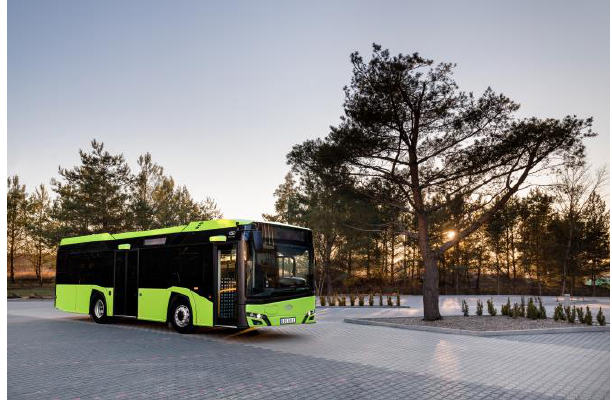
Figure 1. Solaris Urbino 10.5 bus [17] Table. 1 presents the technical data of the Solaris Ur- bino 10.5